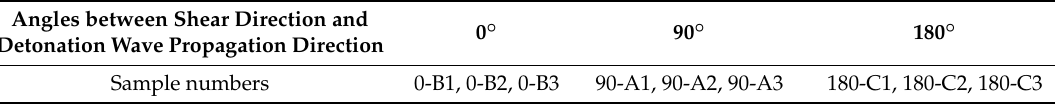
Figure 3. Schematic of: ( a ) the specimen size; ( b ) shear test; and ( c – e ) sampling schemes; ( f ) universal mechanical testing machine. Table 4. List of sample numbers in shear tests (repeated three times).